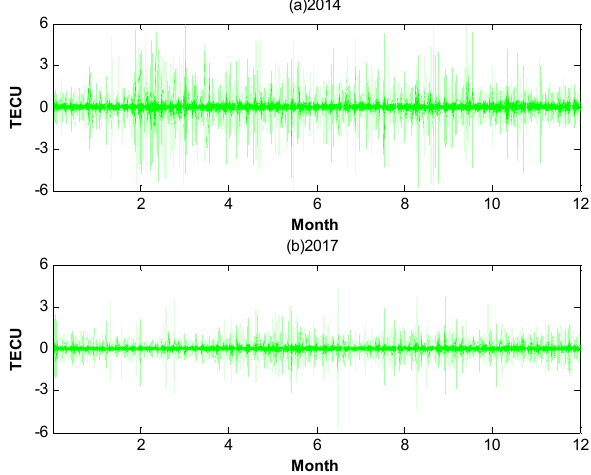
Figure 7. Ionospheric detrended TEC (dTEC) series extracted by GNSS station HKKT during the years of 2014 and 2017.